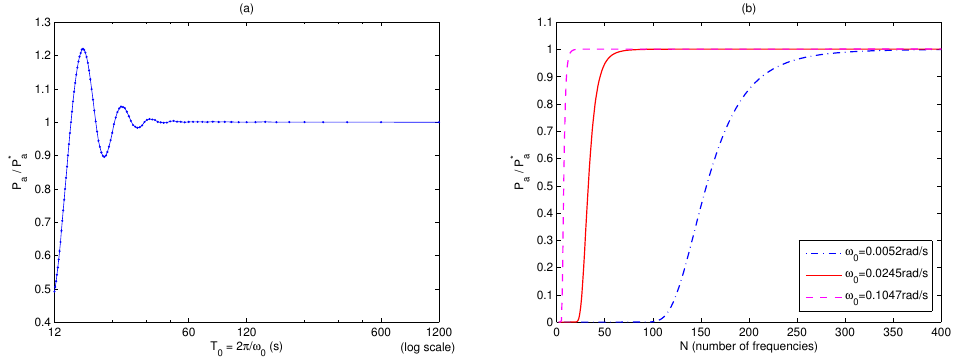
Figure 4. Normalized absorbed power by the cylinder ( r = 5m; d = 10m) as a function of ( a ) the time interval T 0 and ( b ) the number of components of the Fourier series. Panchromatic